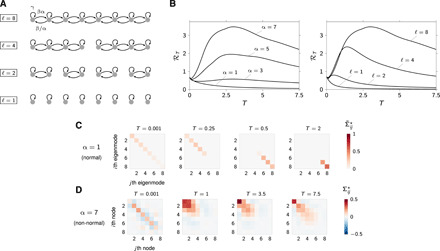
Information rate for chain network.(A) Chain network schematics, with parameter values γ = −2.5, β = 1, σ2 = 1, B = I, and C = I. (B) Plot of ℛT as a function of T for four different values of α (for ℓ = 8) and ℓ (for α = 7). (C) Matrix plot of Σ˜⋆, the optimal input covariance expressed in the eigenbasis of A, for various values of T, ℓ = 8, and α = 1 (normal case). The eigenmodes of A are ordered by increasing decay time constants. (D) Matrix plot of the optimal input covariance Σ⋆ for various values of T, ℓ = 8, and α = 7 (strongly non-normal case).